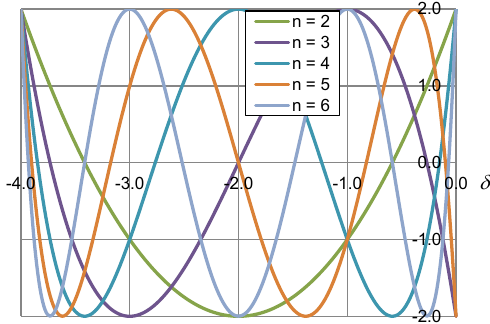
Figure 2. Graphs W n (δ) at different numbers of reservoirs n ; values of k are the same for all reservoirs (model SC).